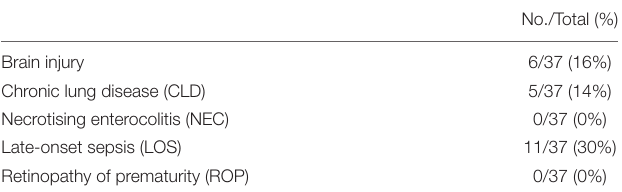
TABLE 2 | Clinical characteristics in VLBW